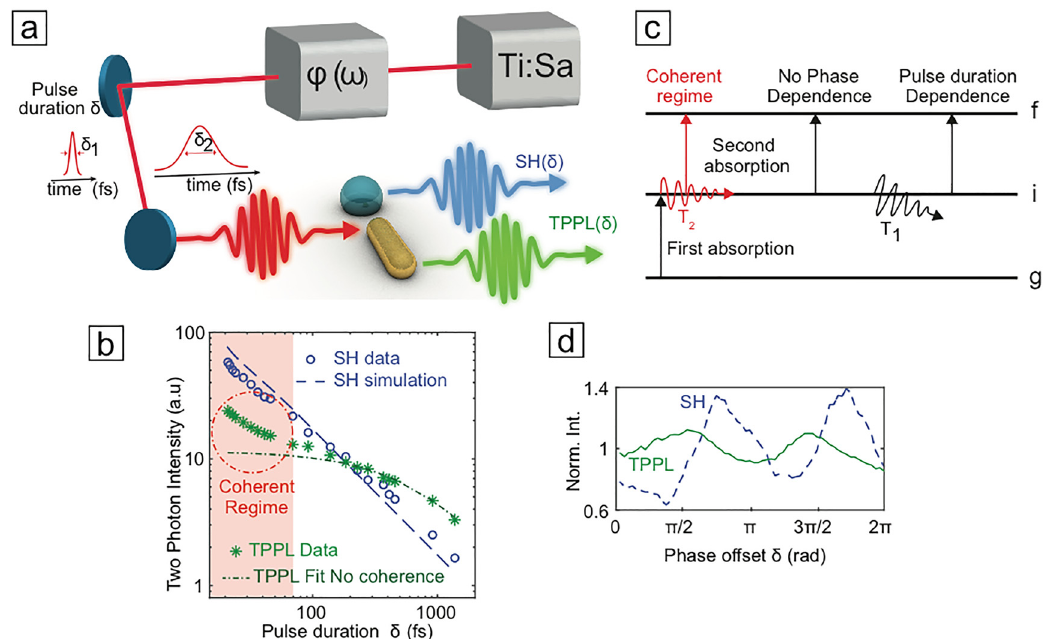
Figure 1: TPPL as a function of the pulse duration. (a)Schematicof theexperiment:apulseshaperchangesthetimedurationof a laserpulseintherangeof 15fs – 1 ps.The TPPLfroma resonant nanoantenna and the SH from a nonresonant BaTiO 3 are detected as a function of the pulse duration. (b) Experimental dependence of the SH (blue circles) and the TPPL from a resonant 90-nm long gold nanoantenna (green stars) on the pulse length δ . The blue dashed curve is the predicted behaviour of the SH, which agrees well with the experiment. The dark green dot-dashed curve corresponds to a fi t to the TPPL for δ > 100 fs using Eq. (1) from which we infer a lifetime of the intermediate state T ≅ 350 ± 50 fs. For pulses shorter than ∼ 50 fs, a coherent 1 regimedevelops.(c)SketchofthethreedifferentregimesinvolvedinTPEasafunctionofthepulselength.(d)Effectofaspectralphasescanon the TPPL from a resonant gold nanoantenna (green curve) and the SH from a BaTiO 3 nanoparticle (blue curve). Note that the modulation depth is substantially reduced for the TPPL response. TPPL, two-photon – induced photoluminescence; TPE, two-photon excitation; SH, second